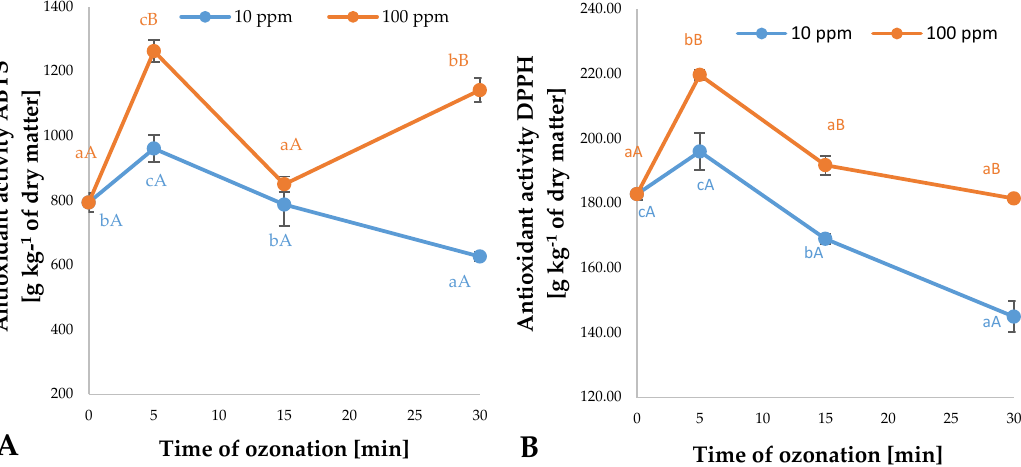
Figure 6. Antioxidant activity. ABTS test (part A), DPPH test (part B) in Rheum rhaponticum L. petioles, depending on the duration of ozone treatment (n = 3). The differences in the results between the ozonation time for individual variants are marked with different small letters and the difference between the measurement values for the tested variants is marked with different capital letters, p < 0.05.